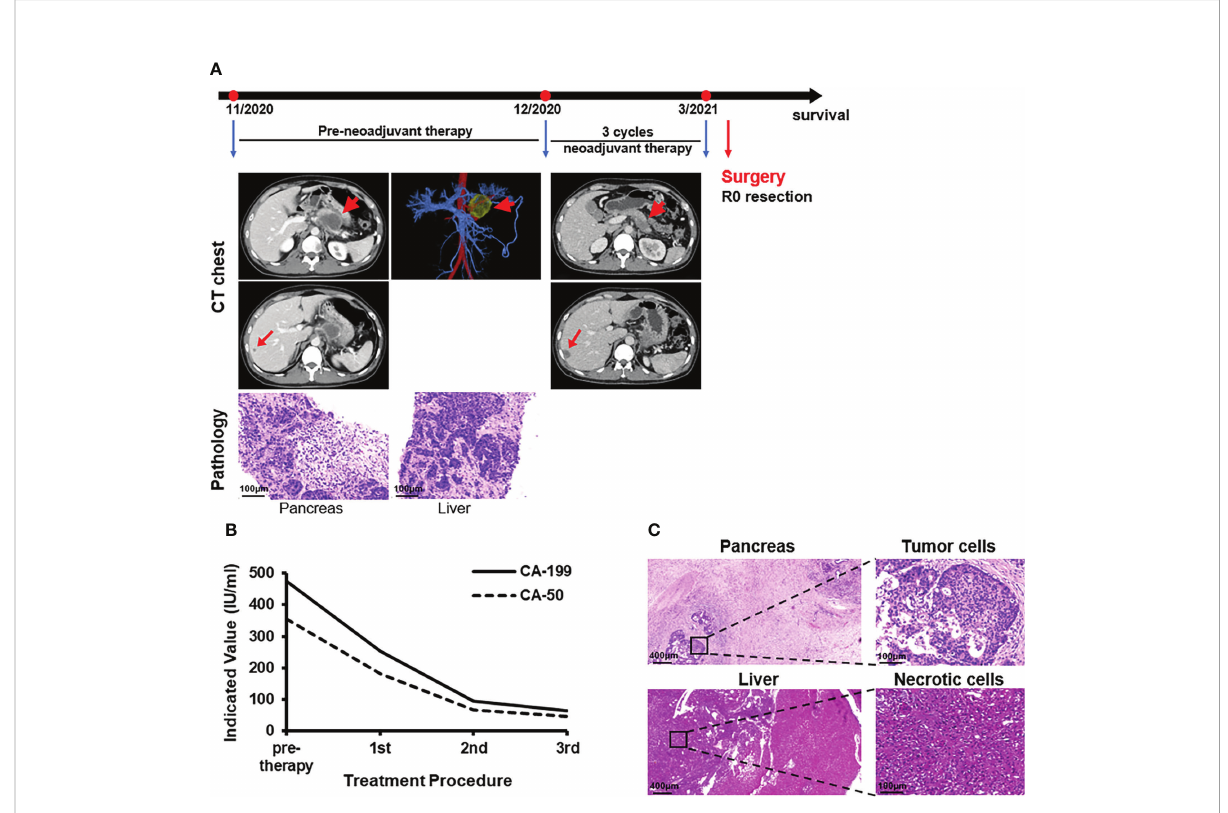
FIGURE 2 Case presentation of patient 2. (A) Timeline of disease status. Tumor responses shown by CT of pre- and post-neoadjuvant therapy and pathological diagnosis of pancreas and liver with fi ne needle aspiration. (B) CA-199 and CA-50 levels during treatment. 1st: receipt of the fi rst PD-1 antibody and AG treatment. 2nd: receipt of the second treatment. 3rd: receipt of the third treatment. (C) H&E staining of the isolated pancreas and liver tissues after